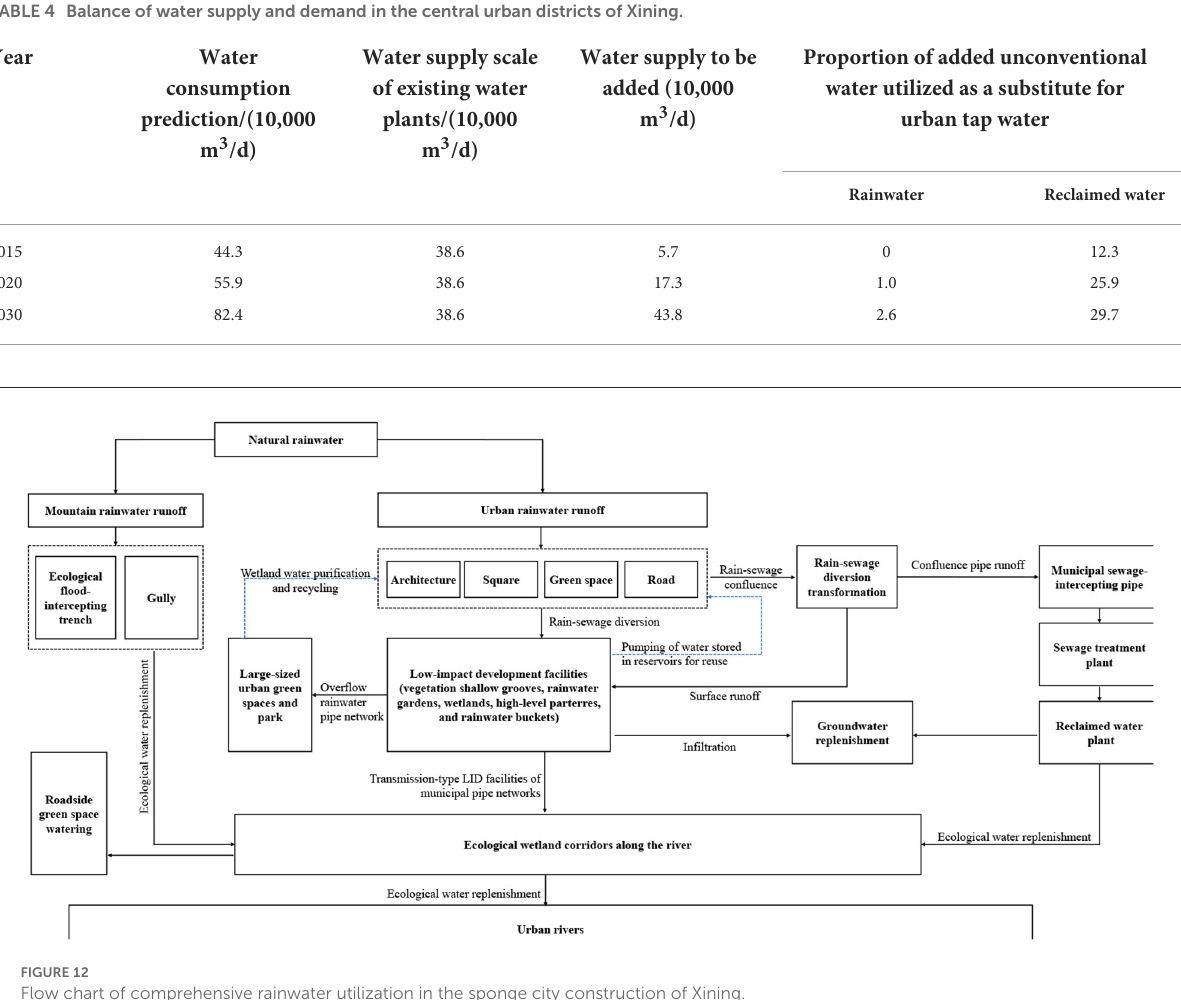
municipal water affairs department. Figure 10 illustrates the technical route of water